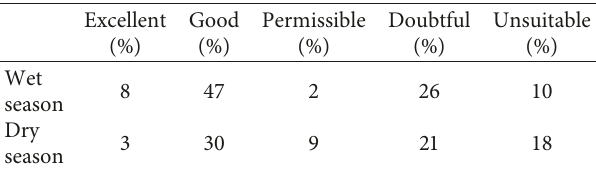
Figure 17: Spatial distribution maps of the irrigation suitability classes of the study area. Table 6: Salinity and alkalinity hazards of irrigation water in US salinity